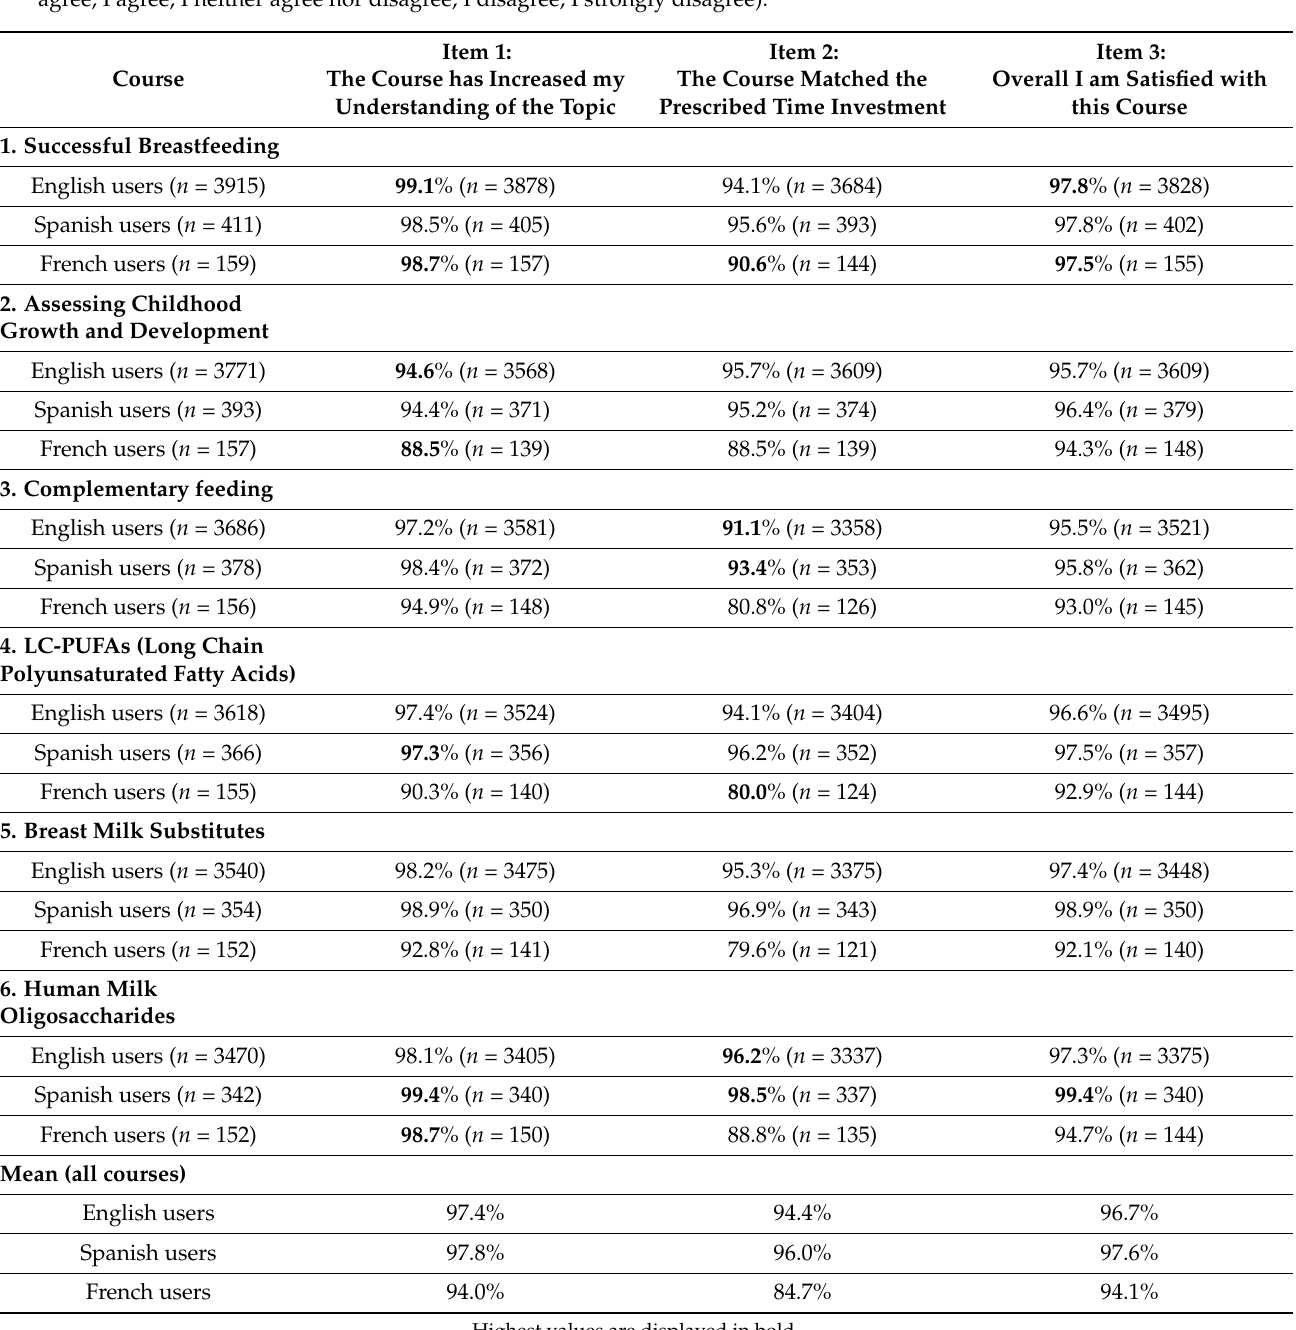
Table 3. Percentage and number of users responding with the answer “I (strongly) agree” to three selected evaluation questions for the six courses. The answer options offered followed a Likert element with five rating categories (I strongly agree; I agree; I neither agree nor disagree; I disagree; I strongly